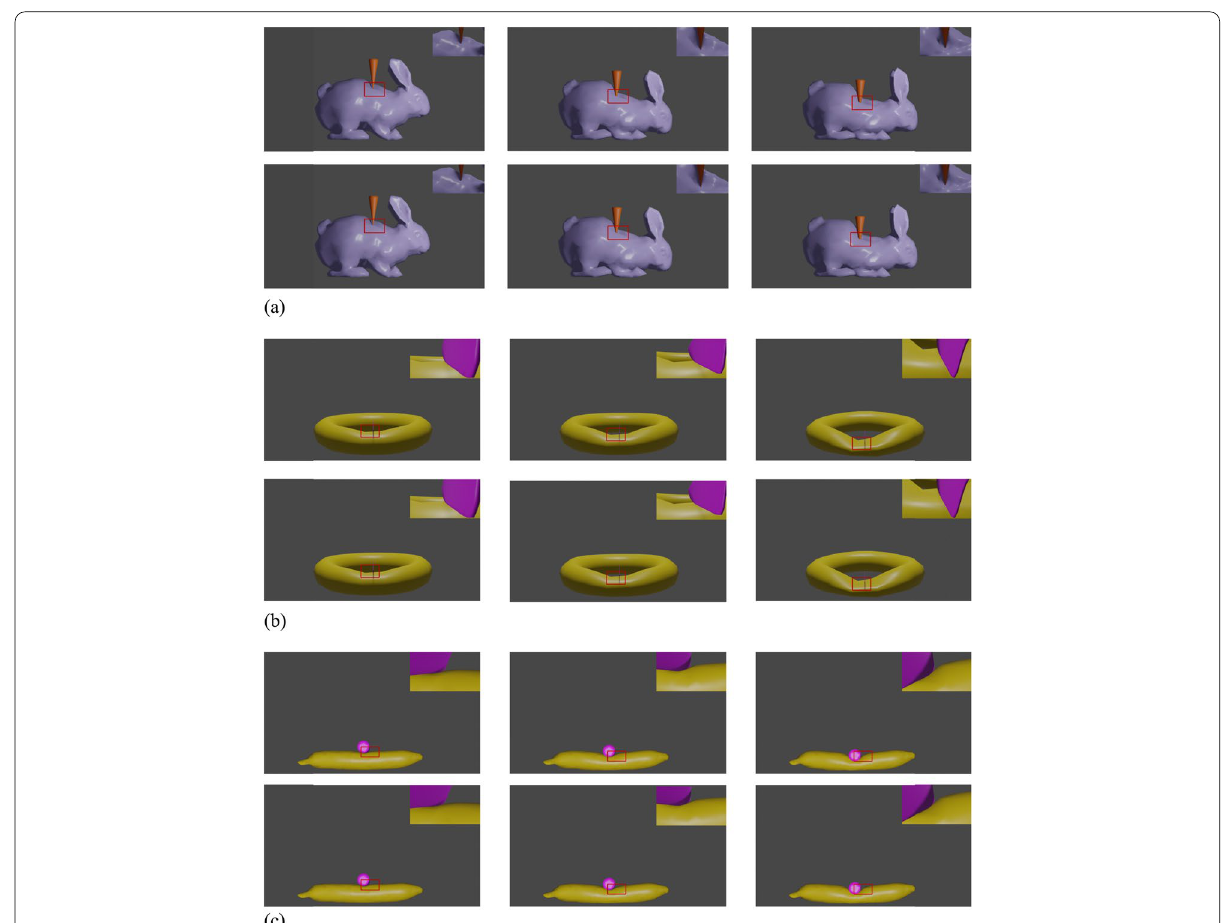
Fig. 7 Qualitative evaluation. The proposed method is evaluated in three different collision scenes: vertex‑face, edge‑face, and face‑face collisions. For each scene, the first row is the simulation result of the proposed method, and the second row is the ground truth. a : Vertex‑face collisions; b : Edge‑face collisions; c : Face‑face collisions